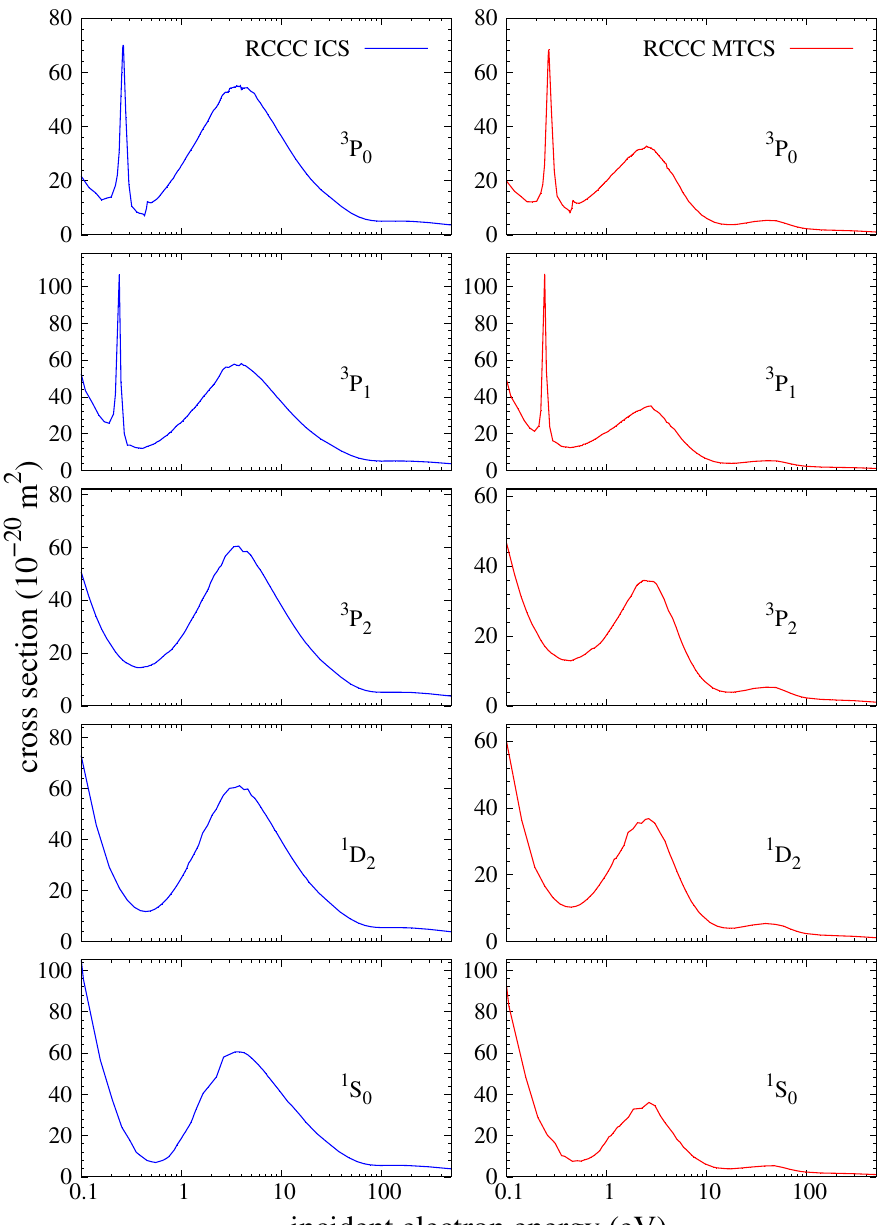
Figure 1. RCCC results for elastic scattering on the ground and first four excited states of neutral tin with the terms (5 p 2 ) 3 P 0 , 3 P 1 , 3 P 2 , 1 D 2 and 1 S 0 . ICS is given by the blue lines on the left and MTCS (momentum-transfer cross sections) by the red lines on the